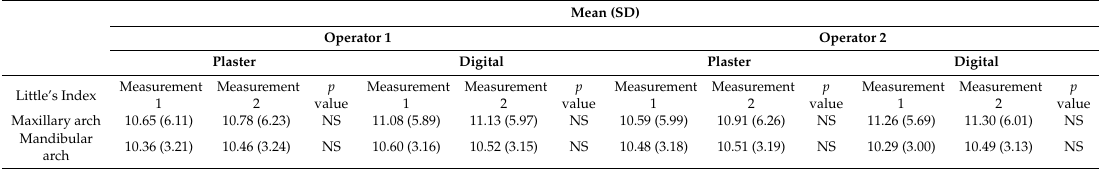
Table 1. Intra-operator reliability for Operator 1 and 2. Units are represented in millimeters. The p value obtained from paired t -tests. NS = non-significant ( p > 0.05).